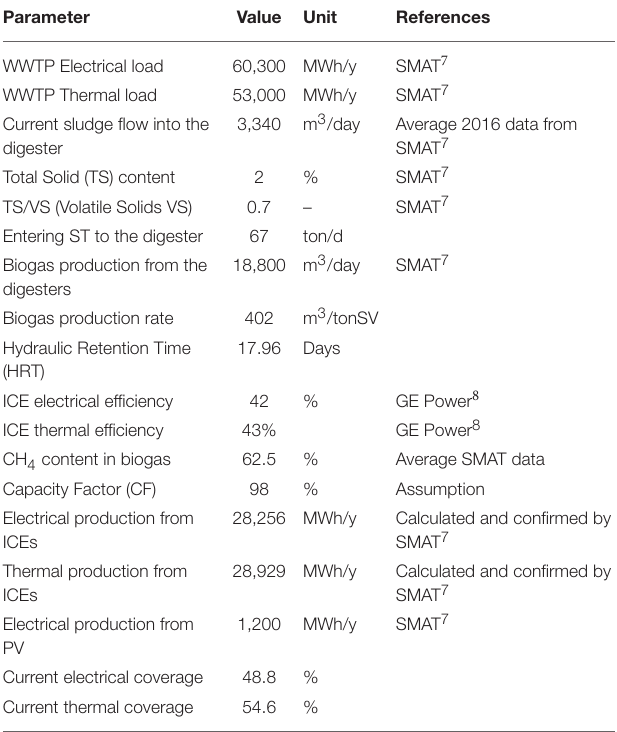
TABLE 7 | Current scenario at SMAT Castiglione